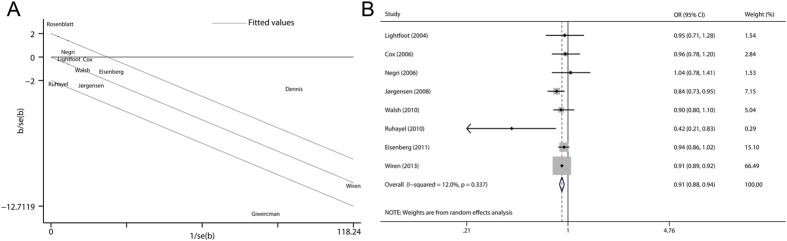
Evaluation of heterogeneity.(A) Galbraith plot analysis was used to detect potential sources of heterogeneity; (B) Pooled risk estimate with its 95% CI for the association between fatherhood status and prostate cancer risk after removing studies that contribute most to heterogeneity.